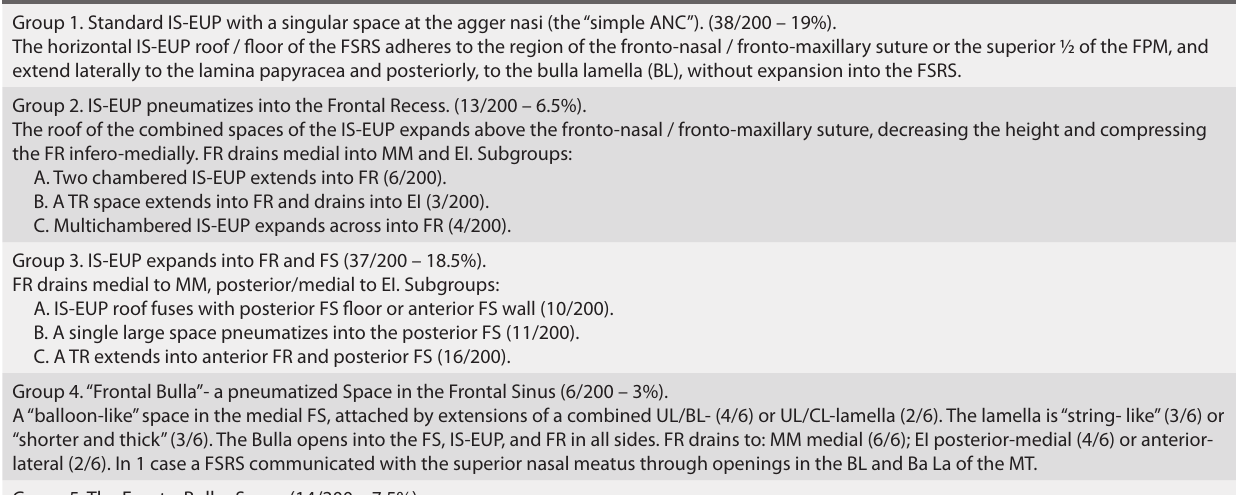
Table2. Grouping according to core features and individual variability of microanatomical spaces of the anterior ethmoid. Core features (groups) and individual variability of microanatomical spaces of the anterior ethmoid. Group 1. Standard IS-EUP with a singular space at the agger nasi (the “simple ANC”). (38/200 – 19%). The horizontal IS-EUP roof / floor of the FSRS adheres to the region of the fronto-nasal / fronto-maxillary suture or the superior ½ of the FPM,